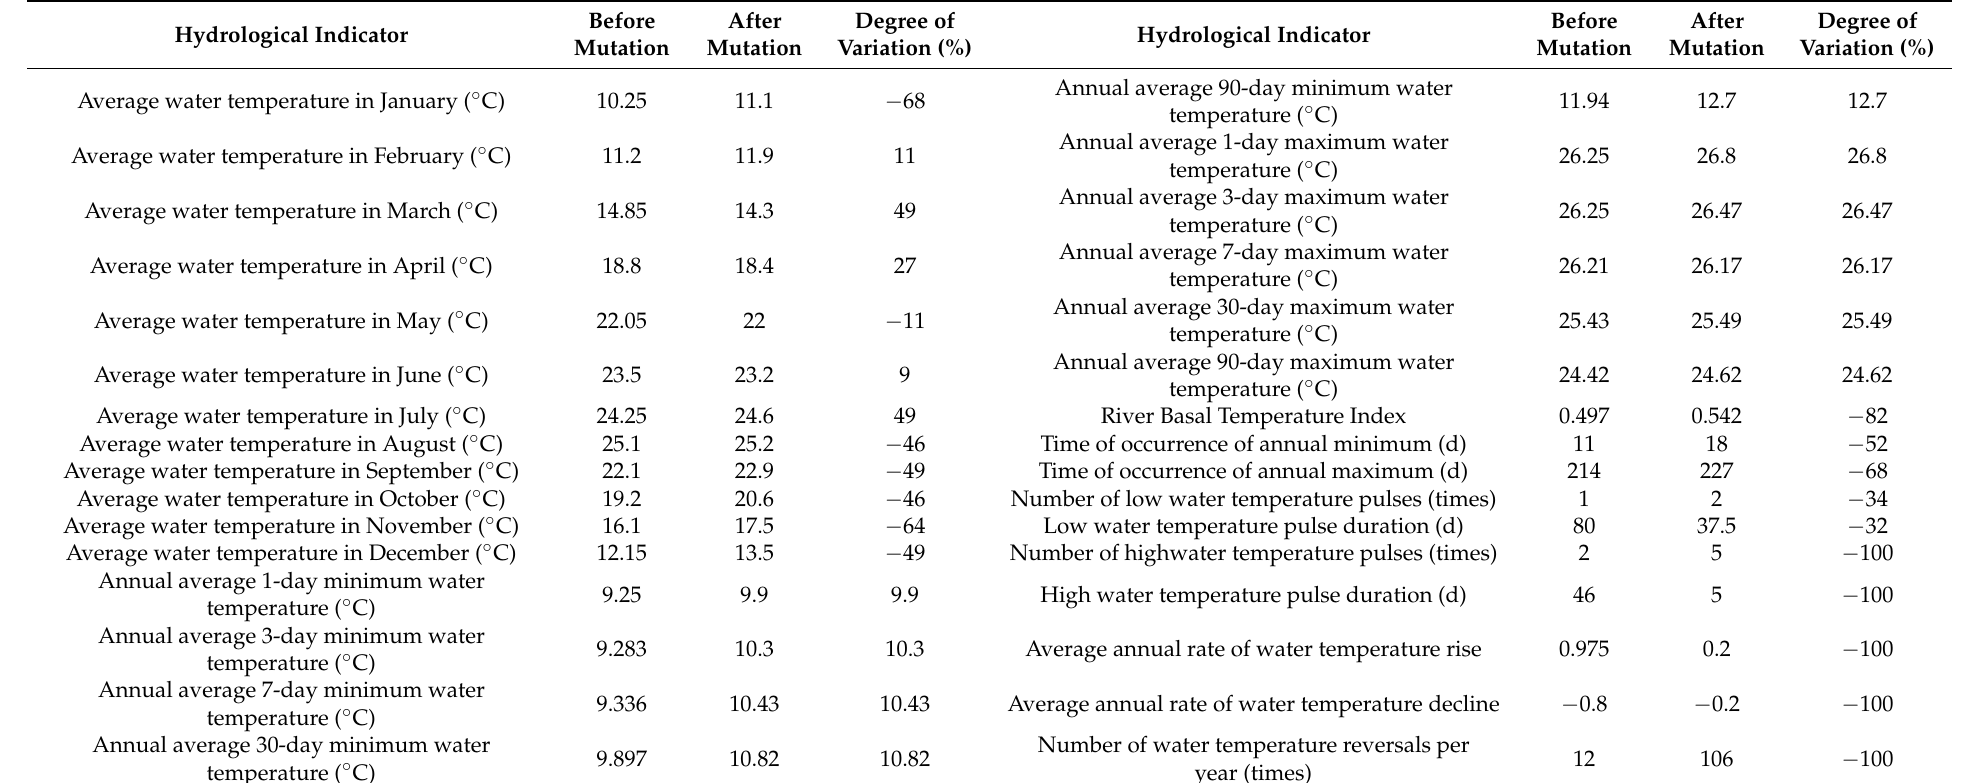
Table 3. Results of the indicator of Water Temperature Variation analysis for Cuntan